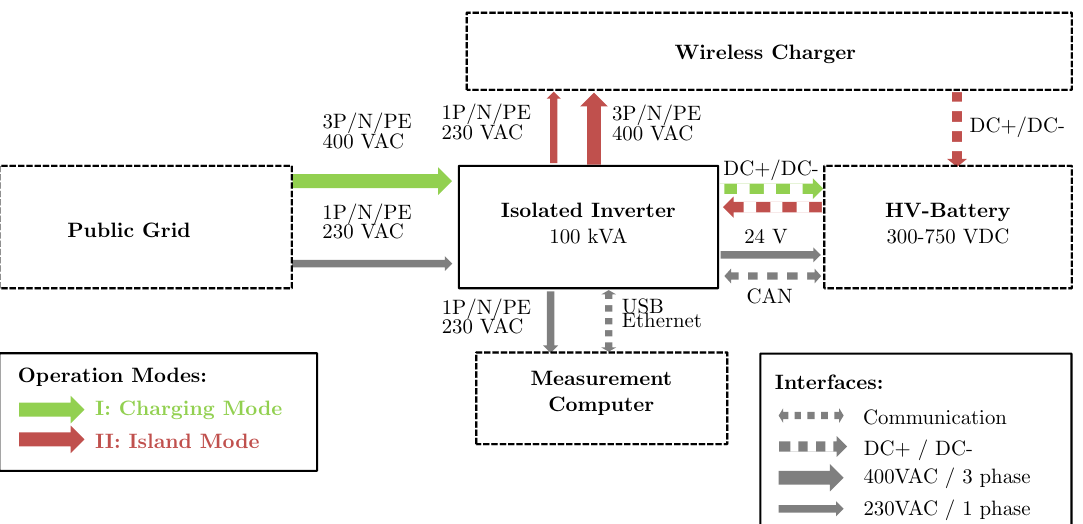
Figure 10. Block diagram of the Hardware-in-the-Loop test bench.